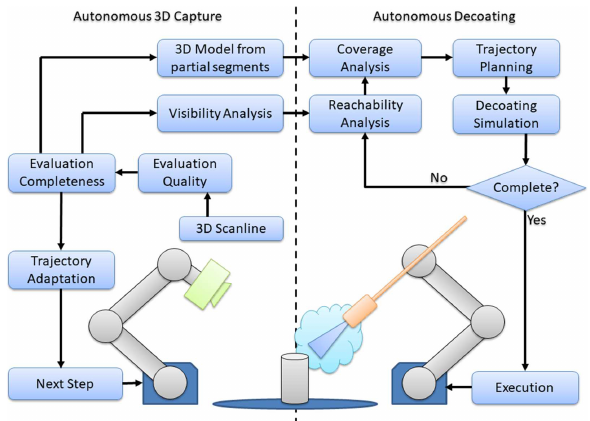
Fig. 1. Autonomous 3D geometry capturing and robot- assisted coating removal – shown here by two robot arms for the sake of